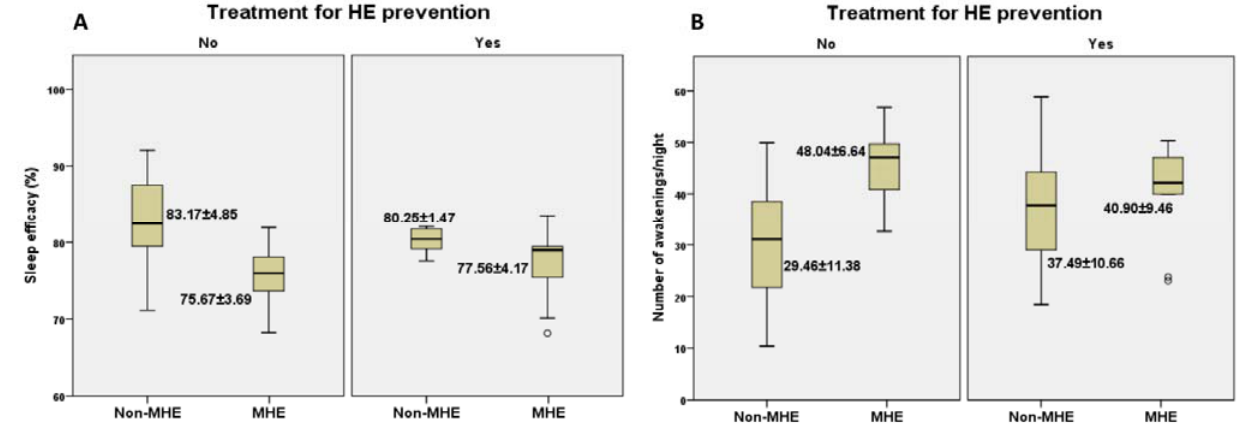
Figure 3. The relationship between the presence/absence of MHE with/without preventive treatment and actigraphic parameters: sleep efficacy ( A ) and number of awakenings/night ( B ).